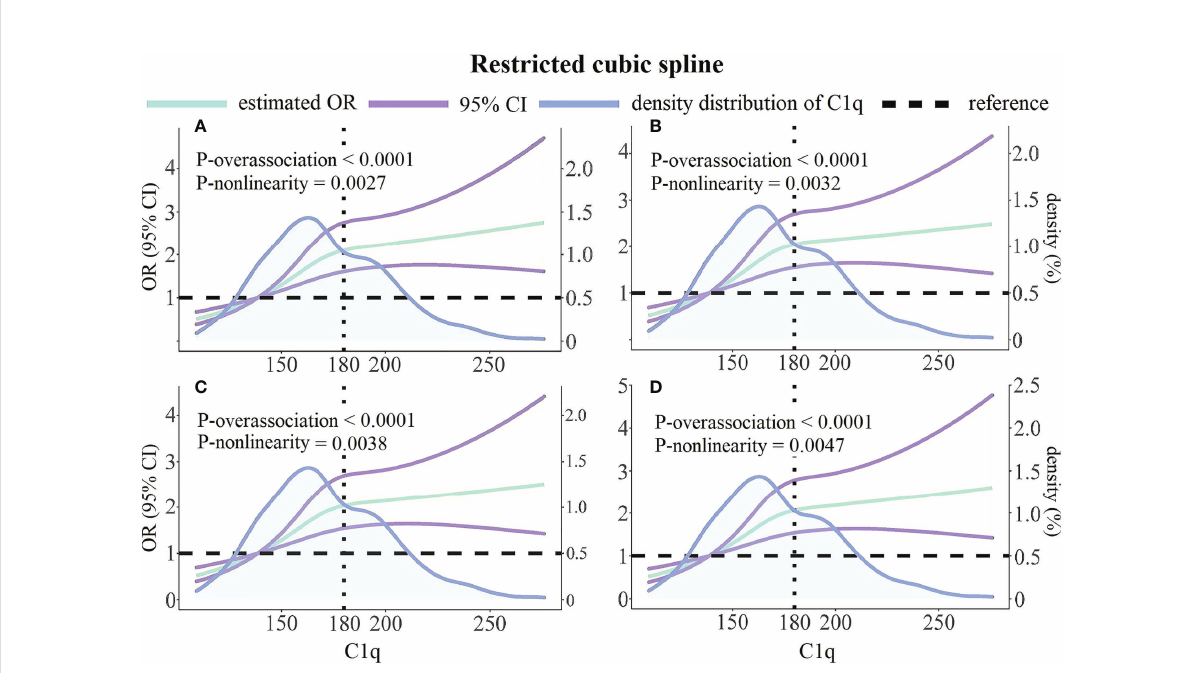
FIGURE 4 Unadjusted and multivariable-adjusted ORs and 95% CIs for HRPR according to C1q and the density distribution curve of C1q. (A) Unadjusted model. (B) Adjusted for variables included in Model 1 as Table 3 described. (C) Adjusted for variables included in Model 2 as Table 3 described. (D) Adjusted for variables included in Model 3 as Table 3 described. Green solid lines represent ORs, with purple lines representing the 95% CIs. Black horizontal dotted lines represent the references corresponding to an OR of 1.0. Blue solid lines describe density distribution of C1q. Reference point is the median of C1q ’ s fi rst quartile with three knots placed at the 25th, 50th and 75th percentiles of C1q. OR, odds; CI, con fi dence